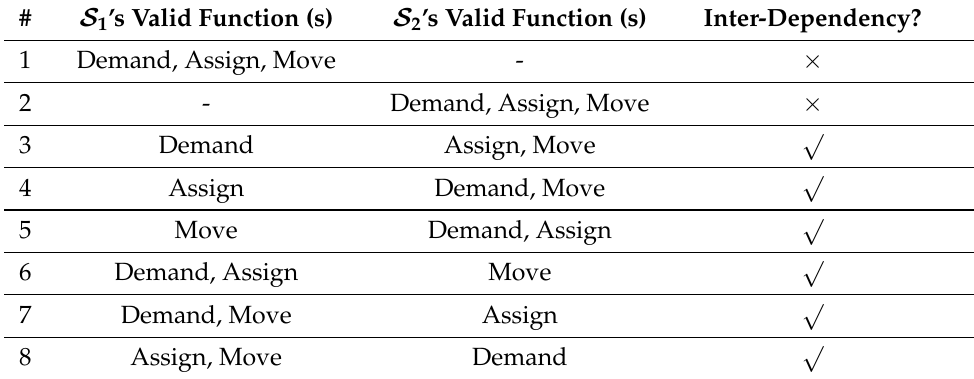
Table 1. The different types of inter-dependency between multi-scale